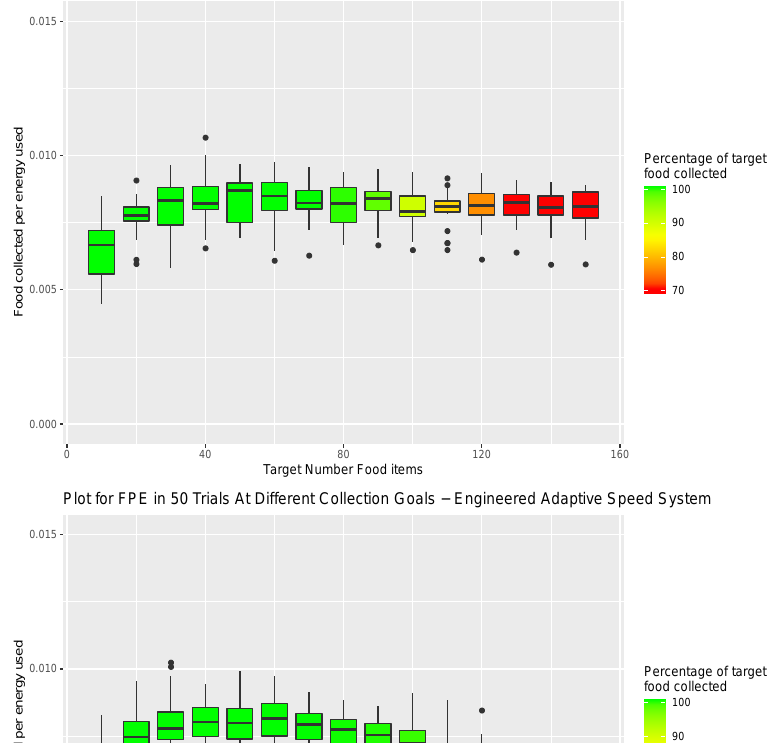
Plot for FPE in 50 Trials At Different Collection Goals − Static Speed System